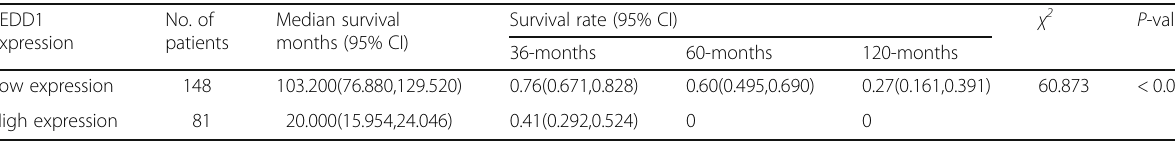
Table 5 Cytoplasmic REDD1 expression and DFS REDD1